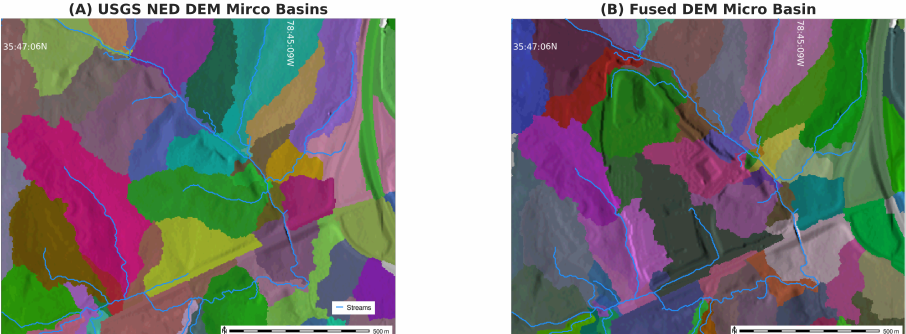
Figure 16. Micro basins derived from the ( A ) USGS NED DEM and ( B ) fused DEM indicate that the development generally preserved the existing